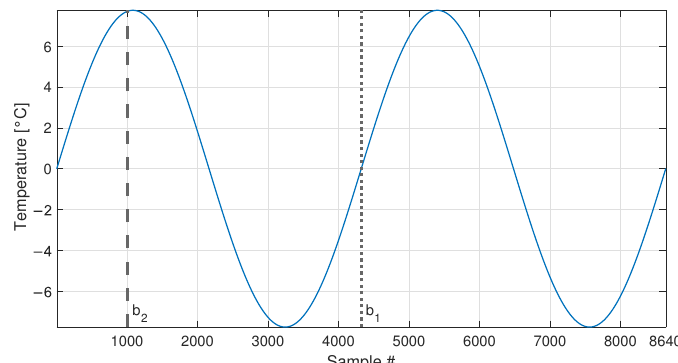
Figure 4. Simulated temperature trend: long-term trend only. Vertical dotted and dashed lines identify the number of samples used as baseline in sim 1 and sim 2, respectively.